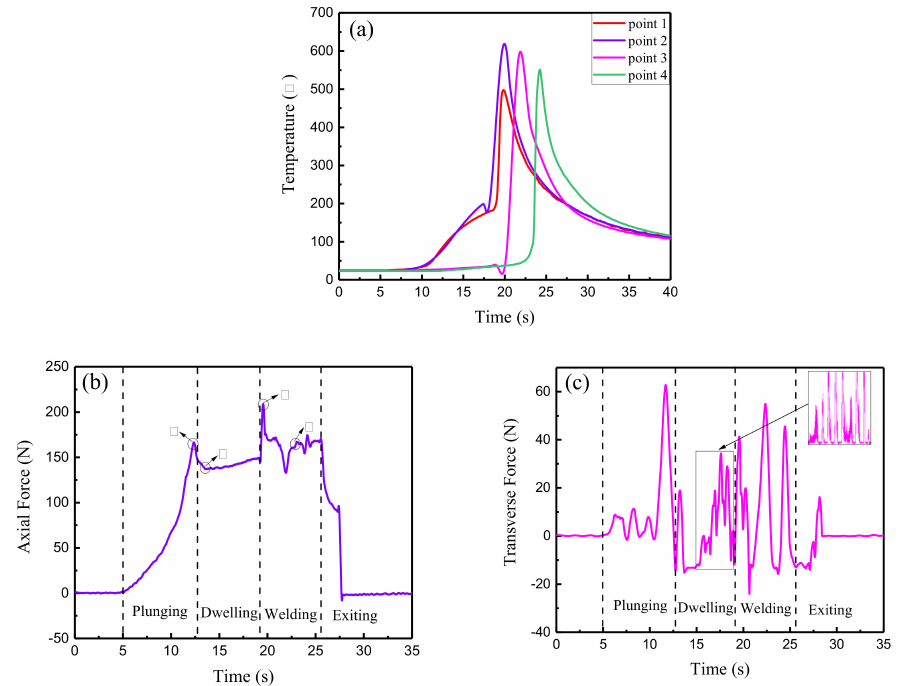
Figure 10. Dynamic change process of physical quantity during micro friction stir welding ( µ FSW) process: ( a ) dynamic temperature-time ( b ) axial force-time ( c ) transverse